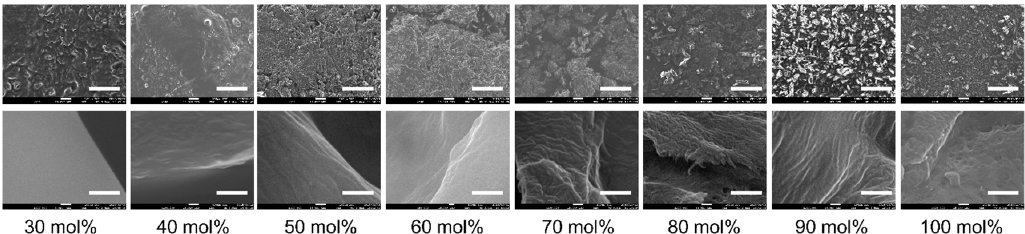
Figure 3. SEM micrographs. White scale bars for the top (100×) and bottom (100,000×) figures represent 300 μ m and 300 nm, respectively.